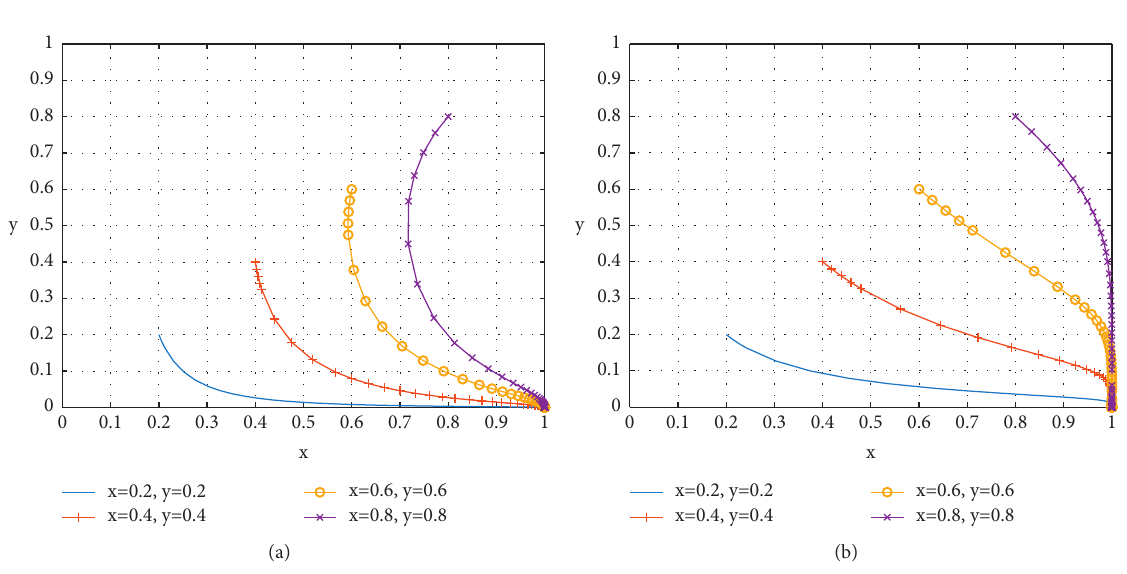
Figure 4: Simulation results of Case